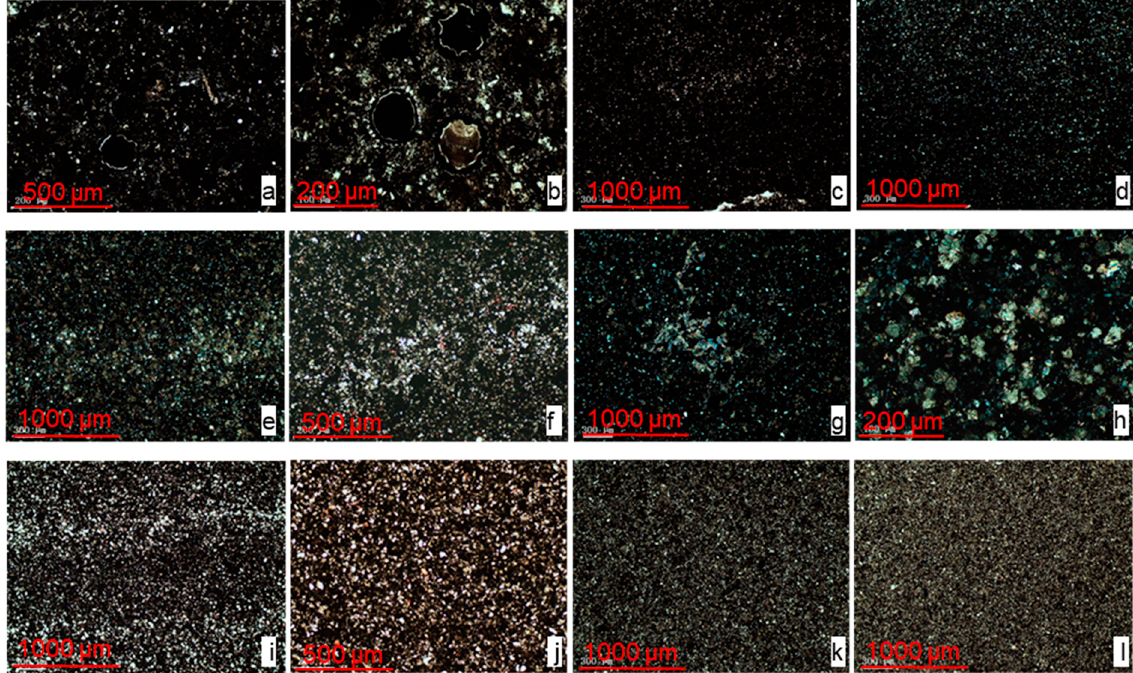
Figure 5. Microphotographs of rock thin sections in Wufeng-Longmaxi Formation from Well A. ( a , b ): carbonaceous siliceous shale, quartz with biological structure, radiolaria; ( c , d ): carbonaceous argillaceous shale, uniform; ( e , f ): composite shale, horizontal lamination; ( g , h ): composite shale, uniform; ( i ): silty shale, silty lamination; ( j ): silty shale; ( k , l ): argillaceous shale, uniform. Table 3. Classification standards of